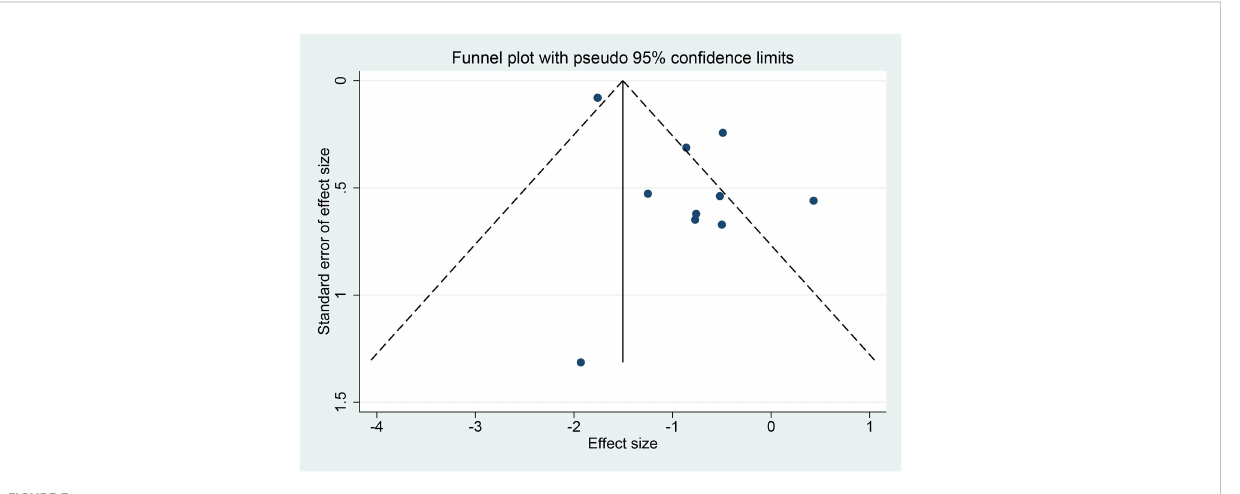
FIGURE 3 Funnel plot of liver stiffness measurement